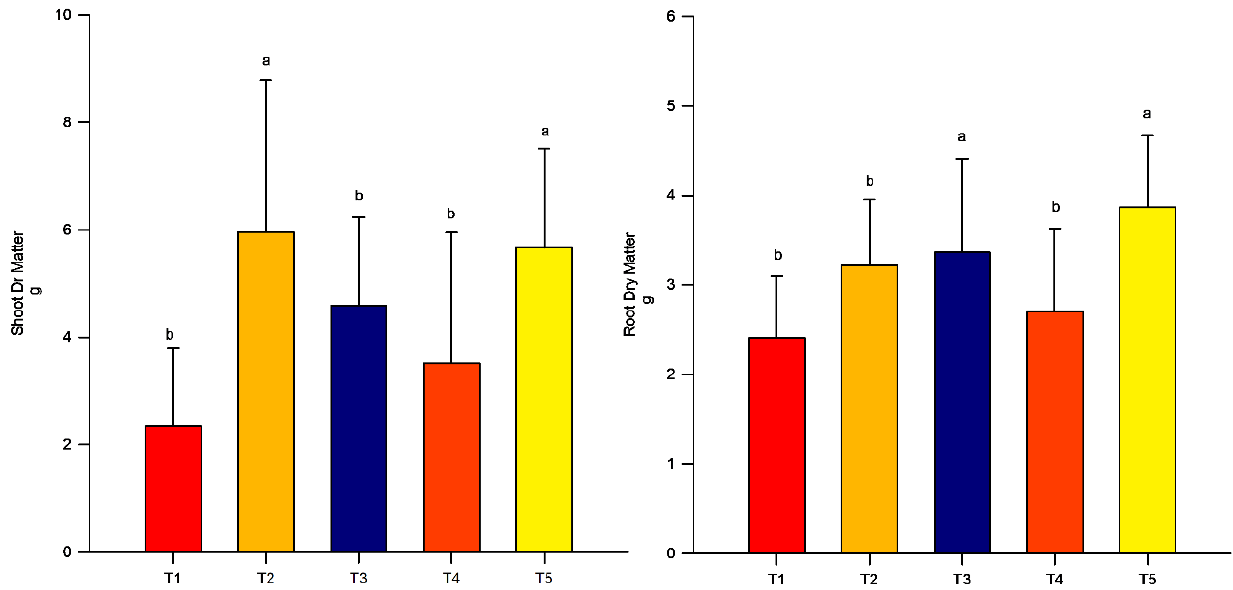
Figure 1. Shoot and root dry matter of potato plants inoculated with different bacteria. Bars represent the standard error of the mean. T1 = control; T2 = B. cereus ; T3 = L. acidophilus ; T4 = S. dextrinosolvens ; T5 = Mix. Means with different letters indicate significant differences among treatments. Statistical analysis was performed using Duncan’s test ( p ≤ 0.05). Letter a indicates the highest value. Letter b indicates the second highest value.